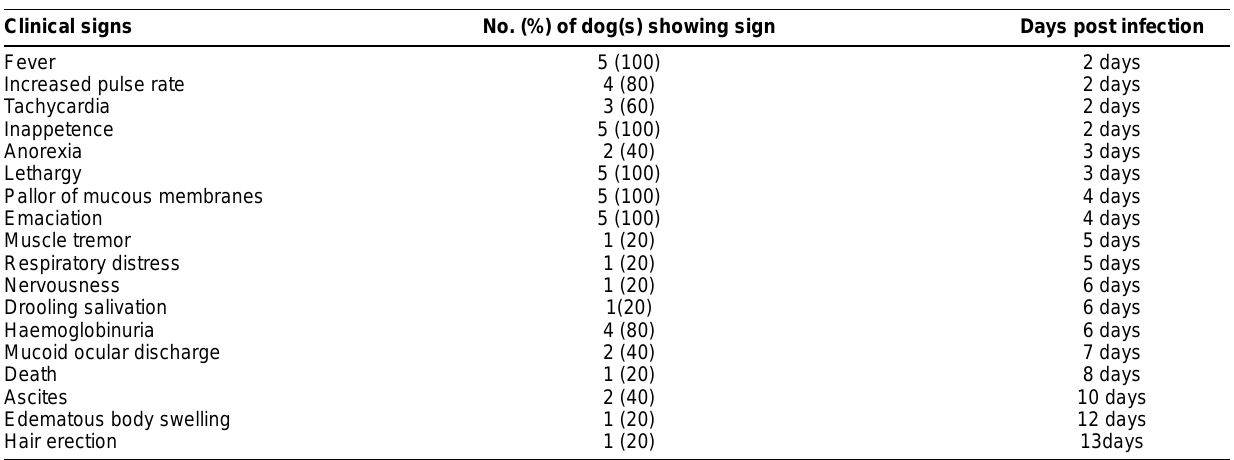
Table-1. Clinical signs associated with Babesia canis infected dogs (n=10) Clinical